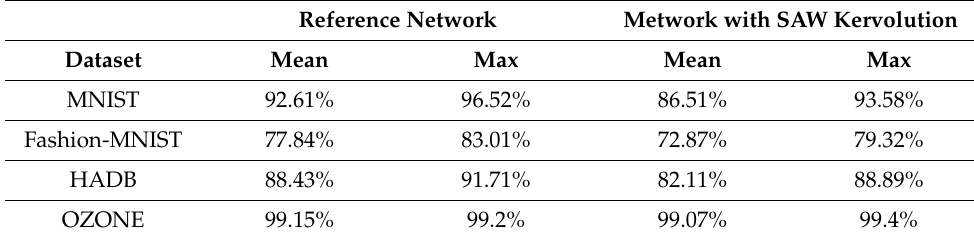
Table 1. This table displays the test accuracies of a traditional convolutional network (as the reference) and our method using an SAW convolver in the different columns. The rows contain the accuracies on four different datasets. As can be seen from the results, the same network provided different mean accuracies for different problems, ranging from 77 to 92% depending on the complexity of the exact task. One can observe an approximately 6% performance drop in almost all cases (except the OZONE dataset), and this drop was independent from the original accuracy of the reference network.